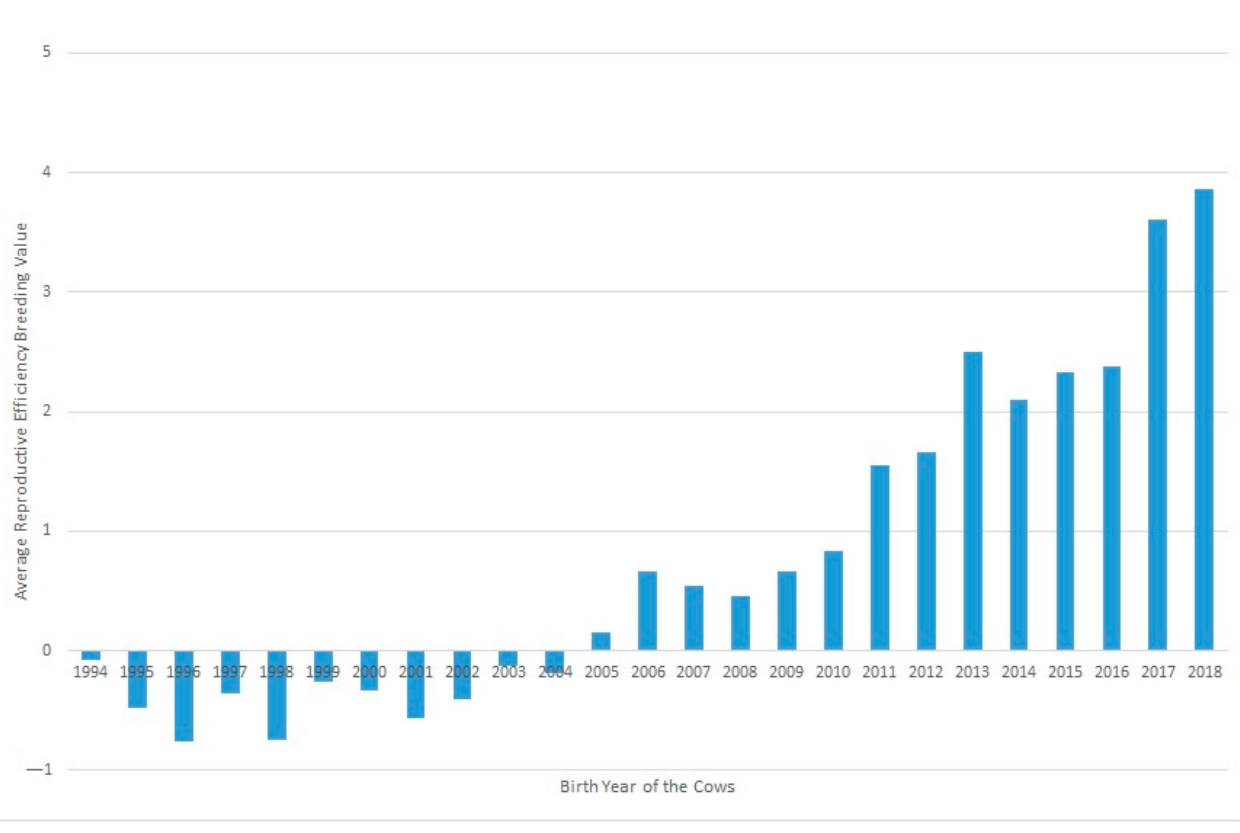
Figure 2. Evolution of the effect of the year of birth on the reproductive efficiency of the cow.